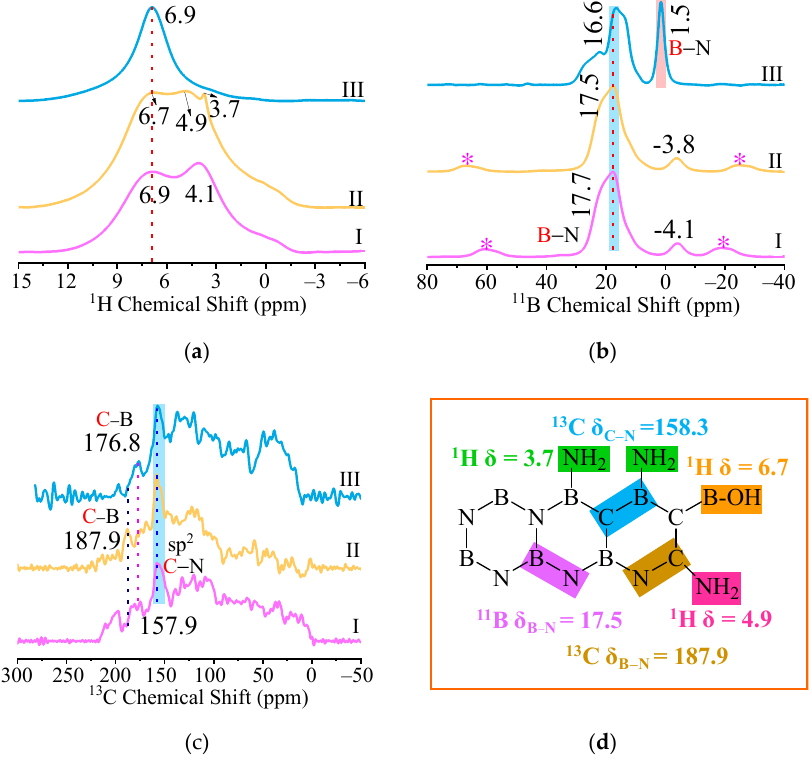
Figure 8. Solid-state MAS NMR spectra of p-BN (I), p-BCN-1 (II), and p-BCN-2 (III) samples: ( a ) 1 H MAS NMR spectra; ( b ) 11 B MAS NMR spectra. * denotes spinning side band; ( c ) 13 C MAS NMR spectra; and ( d ) the idealized structure determined by analysis of p-BCN-1.